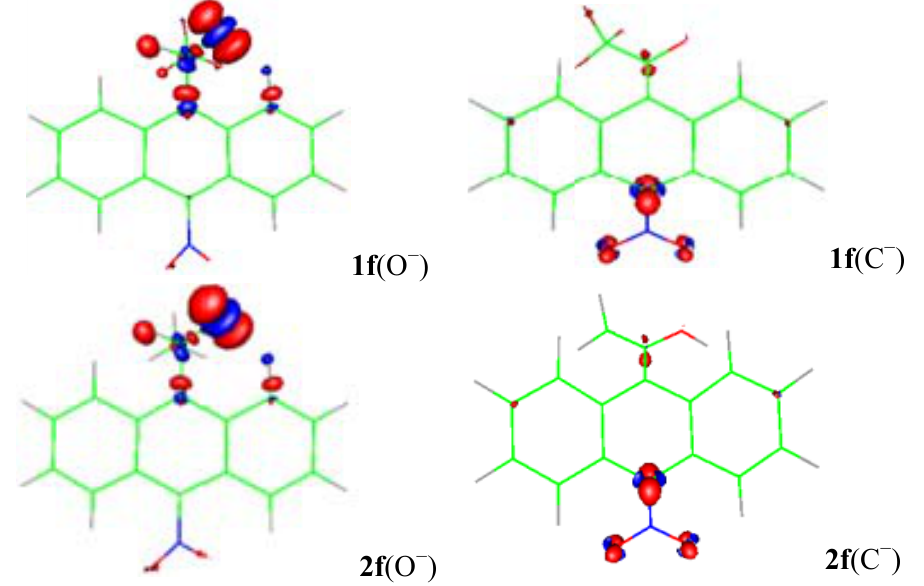
Figure 4. The surface plot of the electrophilic Fukui function for the alkoxides (O − ) and carbanions (C − ) of 1f and 2f